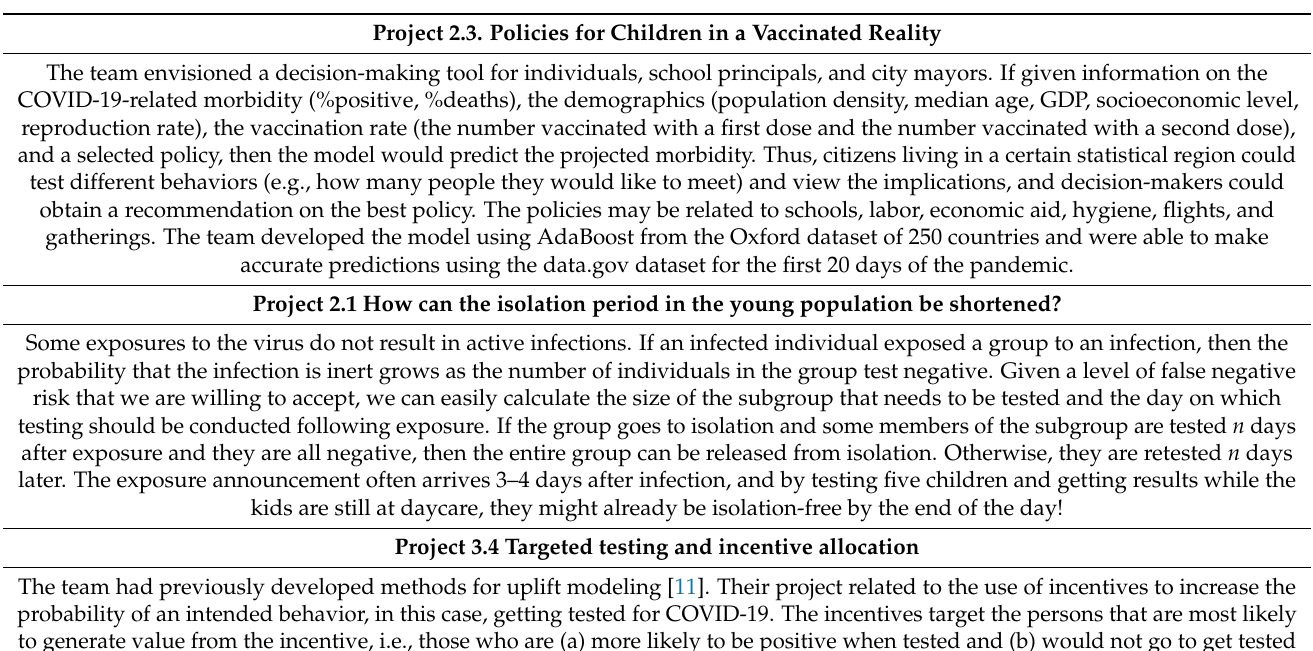
Table 5. Details on the three top